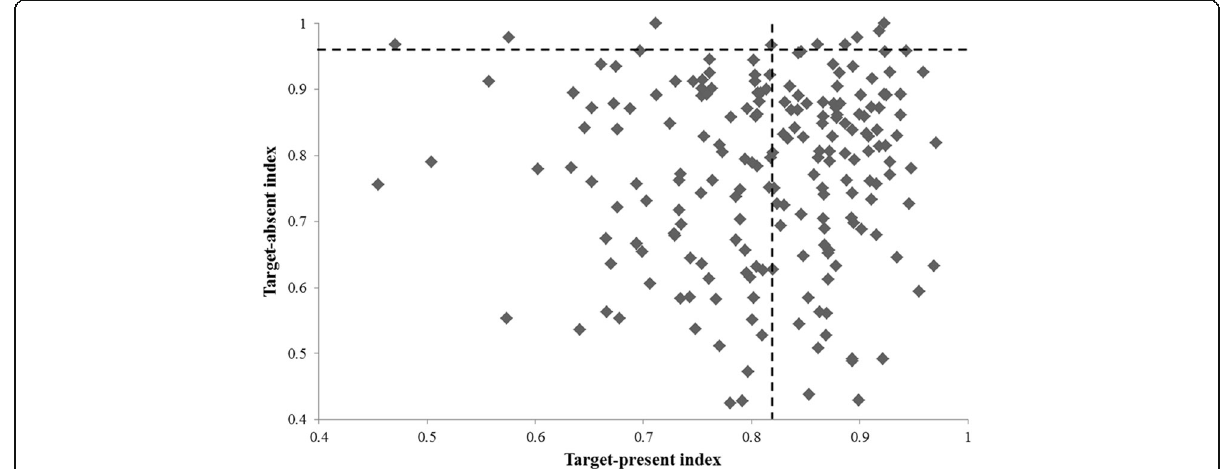
Fig. 7 Correlation between the experimental group ’ s target-present and target-absent indices of